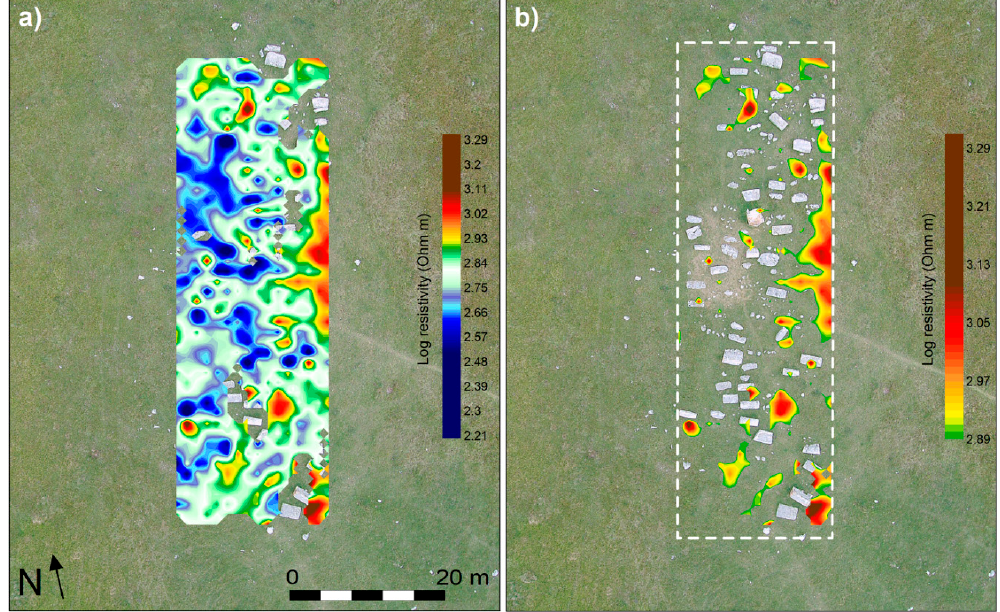
Figure 22. Ste ć ci of Novakovi ć i: electrical resistivity map relative to 1 m in depth using two different colour scales according to which lower resistivity values are visualized through the shades of blue ( a ) or are made transparent ( b ).